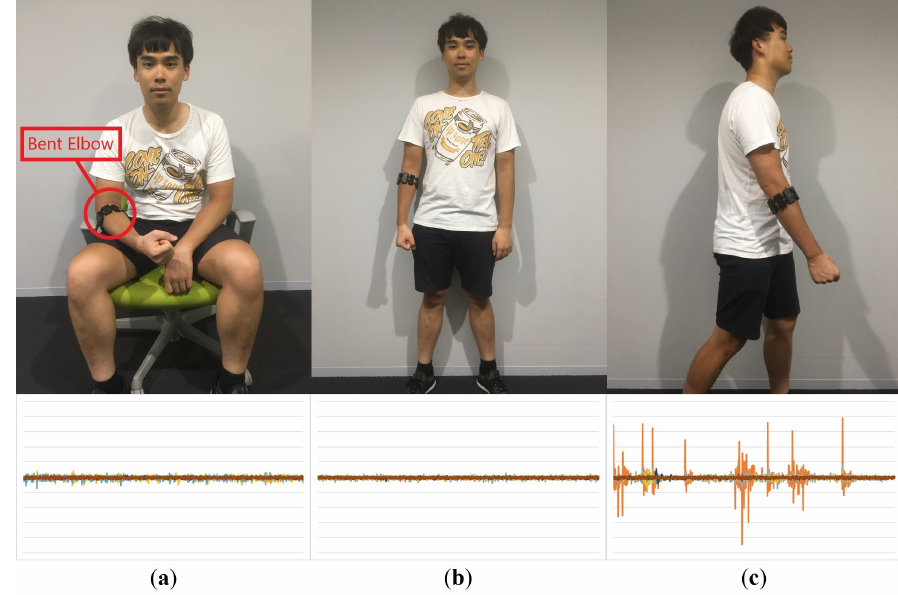
Figure 2. The scenarios used during the performance of the gesture: ( a ) Sitting scenario. ( b ) Standing scenario. ( c ) Walking